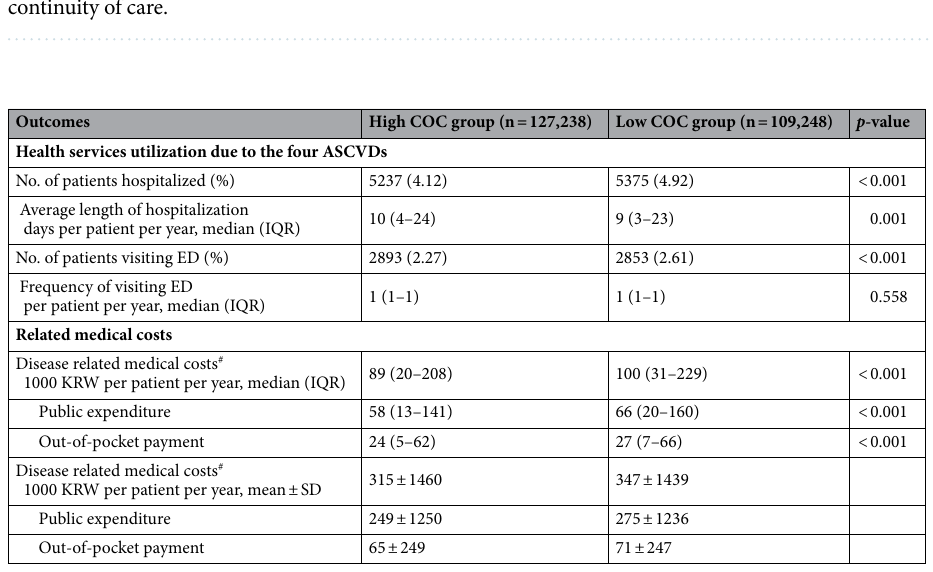
Table 4. Health services utilization and related medical costs by level of continuity of care. ASCVD atherosclerotic cardiovascular disease, CI confidential interval, COC continuity of care, ED Emergency department, HR hazard ratio, IQR interquartile range, SD standard deviation. a Diseases related medical costs included costs for treating dyslipidemia and dyslipidemia related four ASCVDs; 1 US dollar = 1200 KRW in Aug 2021. P -values were calculated by Kruskal–Wallis tests for continuous variables, and Chi-squared tests for categorical